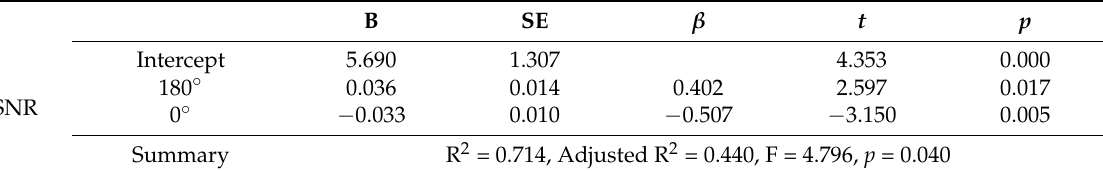
Table 5. Summary of the multiple regression analysis for listening effort and speech segregation from background noise tasks (0 dB and − 6 dB SNR) in two groups.